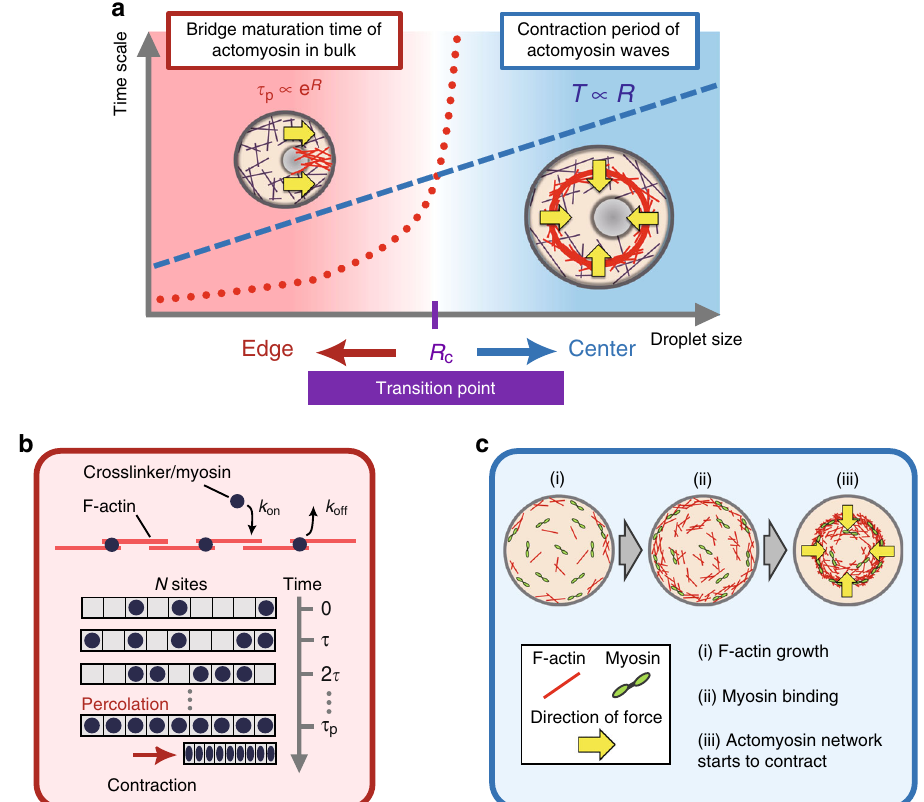
Fig. 6 Theoretical modeling of the two-state cluster positioning. a The proposed mechanism underlying droplet size-dependent two-state cluster positioning. The red dotted curve and blue dashed line represent the bridge maturation time τ p and the wave period T , respectively. Actomyosin waves transport the cluster toward the droplet center every period of T , while stochastically formed actomyosin bridges (mean maturation time τ p ) transport the cluster towards the droplet boundary. Actomyosin bridges are stochastically formed in the time period T between actomyosin waves. If bridges are formed, the network contraction pulls the cluster toward the droplet boundary until the subsequent wave collides with the cluster. Since the characteristic time- scales of two antagonistic forces have different size dependences, the transition radius R c is determined by one unique crossover point. The resultant stable position is determined by the matured network faster than the other. b The percolation model of actomyosin bridge formation. We describe the stochastic binding/unbinding dynamics as the percolation process, wherein crosslinking sites are occupied by crosslinkers with a probability of 1/2 in every turnover time step τ . If all sites (the total number N ) are occupied by crosslinkers, an actomyosin bridge is formed between the cluster and the droplet boundary, and the cluster is transported toward the droplet boundary via actomyosin bridge contraction. The mean percolation time τ p is de fi ned as the number of time steps necessary to form the actomyosin bridge on average, and k on and k off indicate the binding and unbinding rates of crosslinkers, respectively. c An active gel model of periodic actomyosin wave formation. The wave period is determined by the sum of three sequential processes: (i) actin network formation by F-actin growth, (ii) stress generation by myosin binding, and (iii) the ring starts to contract toward droplet D c = 85 μ m (Fig. 2k). The obtained value of τ is similar to the literature value τ = 0.54 s, given that k off = 0.66 s − 1 , k on = 1.2 ×